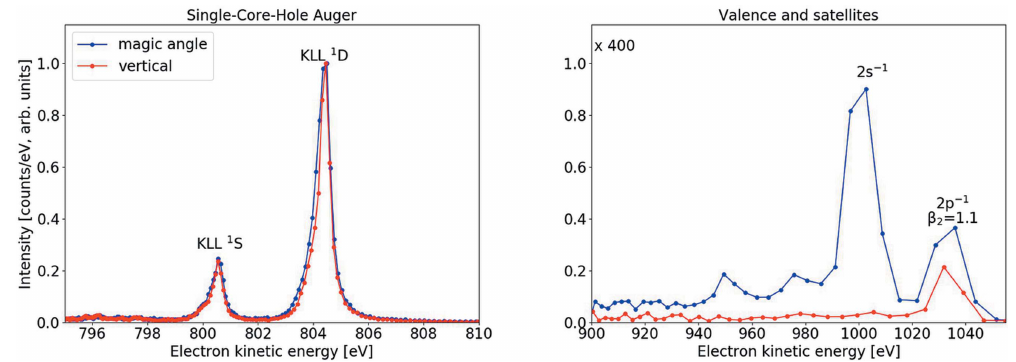
Figure 8 Electron spectra of Ne measured at the SQS instrument with a photon energy of 1050 eVand a retardation of 790 V. The spectrometers are in the dipole plane, vertical (red) and at the magic angle (blue). The spectra on the right are scaled up (cid:8) 400 for visibility